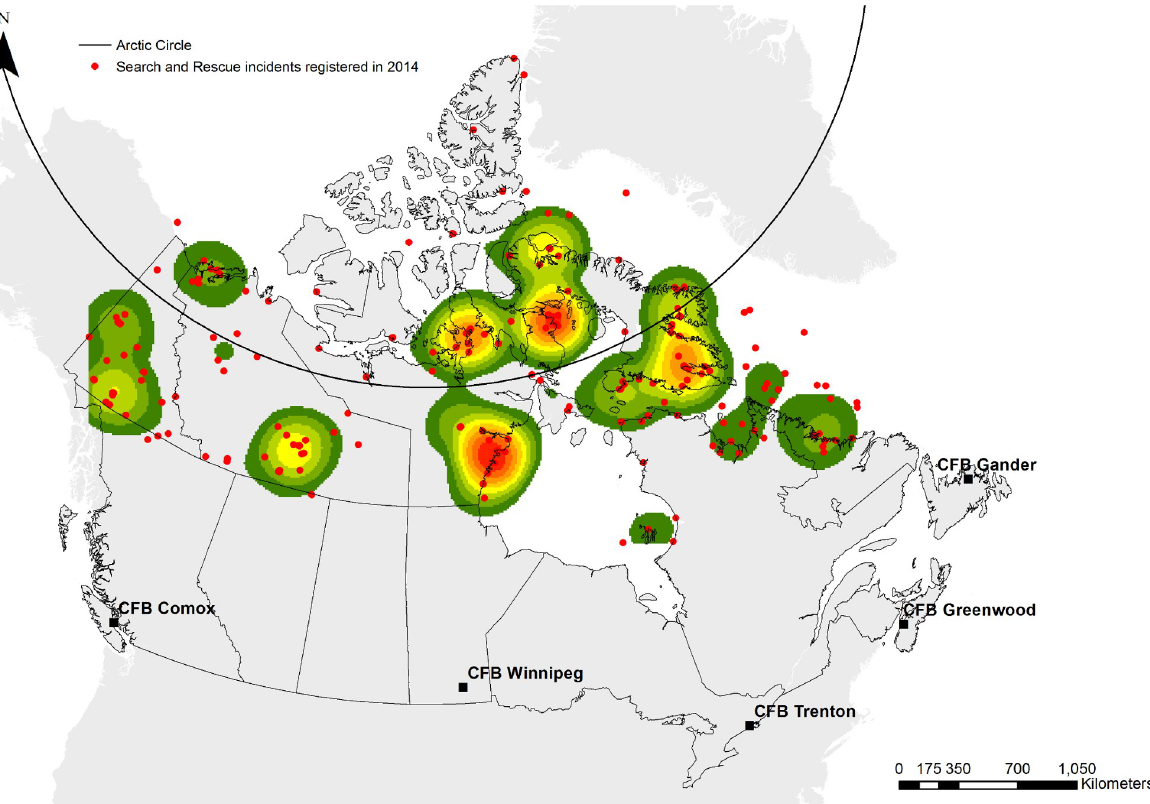
Fig 1. Canadian Arctic search and rescues. In 2014, there were 543 SAR incidents above 55 o N. This map depicts the hot spots of incident location. Data from National Search and Rescue Secretariat. Basemap shapefiles are modified and republished from Government of Canada under a CC BY license, with permission from Natural Resources Canada and Crown-Indigenous Relations, original copyright 2018. Contains information licensed under the Open Government License–Canada